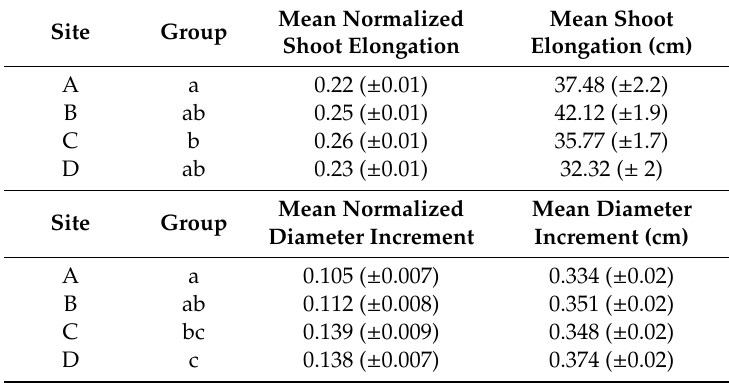
Figure 3. Normalized values of diameter increment ( a ) and shoot elongation ( b ) measured throughout the growing season of 2018. Notice the peaks-and-trough pattern in ( a ), which points to a decrease in the diameter increment during the season. Error bars represent the standard error. 3.2. Allometric Relationships The slope coefficients in the linear regression function, modelling the allometric scaling of the crown volume vs. tree height, did not show significant differences among sites (Figure 4).